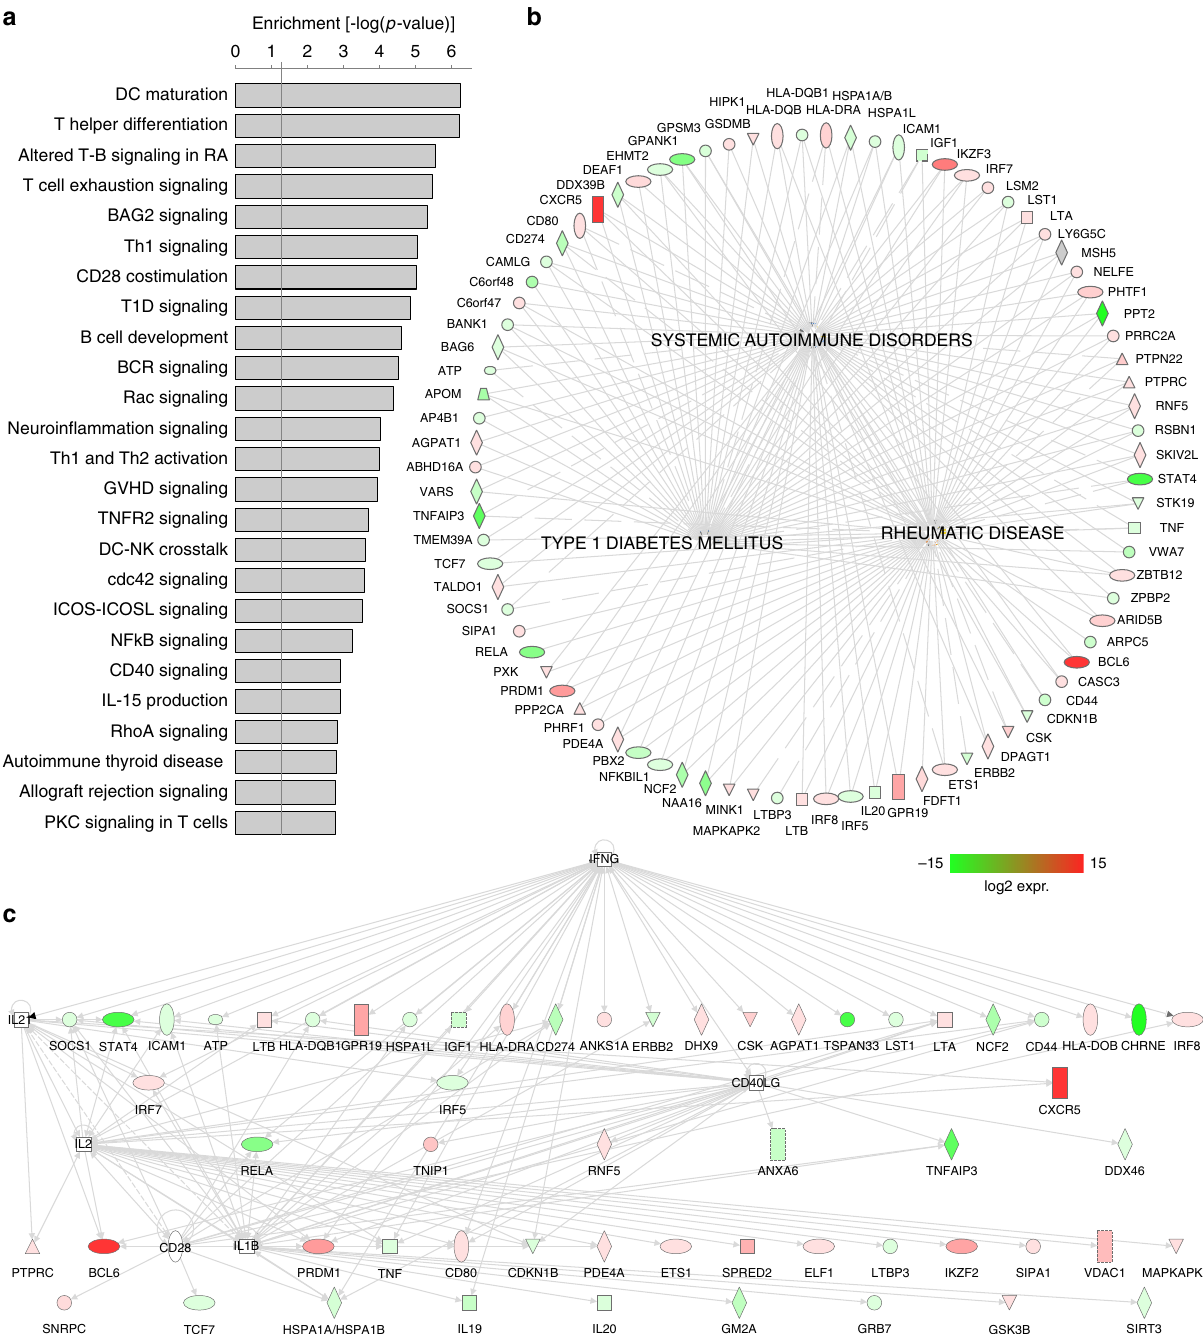
Fig. 7 Ontology and pathway analysis of genes implicated through integration of GWAS and promoter-open chromatin connectomes in follicular helper T cells from human tonsil. a Enrichment of the top 25 canonical pathways ( a ) and 3 disease networks ( b ) among genes implicated through promoter-open chromatin connectomes in TFH as measured by one-sided Fisher exact test in the IPA platform. c Regulatory hierarchical network from SLE-connectome-implicated genes. Color gradients in b , c represent log2 expression changes between TFH and naive T cells, with green indicating downregulation and red indicating upregulation in TFH. Blue nodes in c represent regulatory hubs for genes with no SLE-OCR connectome differentiated in vitro from naive CD4 + T cells 32 (Fig. 9b, c) diphosphooligosaccharide biosynthesis ( DPAGT1 ), and valine degradation ( HIBADH ). Two of these genes, HIPK1 and MINK1 with a lentiviral vector expressing shRNA targeting the HIPK1 (Fig. 9a, Supplementary Fig. 3m, n), encode a homeobox- transcript (Fig. 9d), or with scrambled or B2M shRNAs as interacting kinase and a MAP3/4K homolog that each regulate controls (Supplementary Fig. 10). Transduced cells were sorted, gene expression in other cell types 30,31 . Both HIPK1 and MINK1 restimulated with CD3/28 beads, and secretion of IL-21, the are upregulated in TFH, and their promoters interact with OCR major cytokine required for T cell help for B cell antibody that are genetically associated with SLE risk, suggesting they are production, was measured in the supernatant by ELISA. Tar- involved in TFH function. To test this, we transduced TFH geting of HIPK1 expression had no effect on in vitro TFH